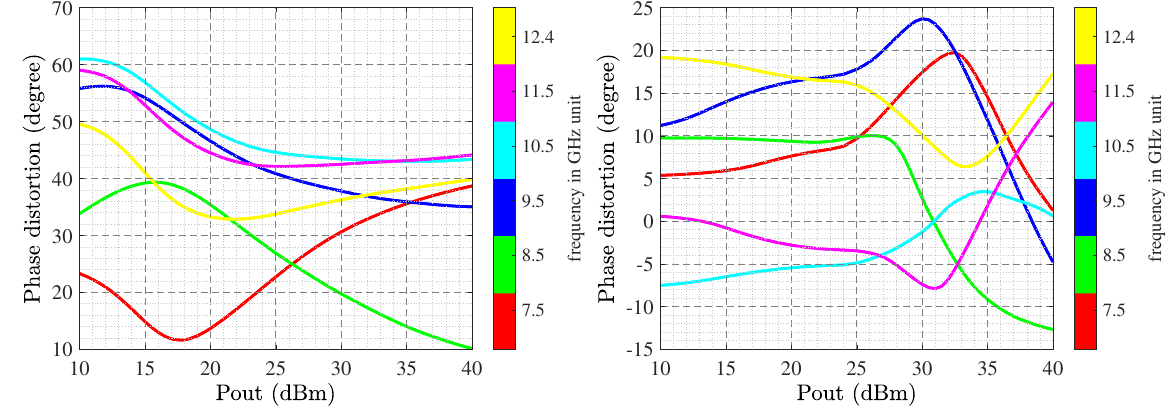
Figure 13. Linearity comparison before ( right ) and after doing optimization ( left